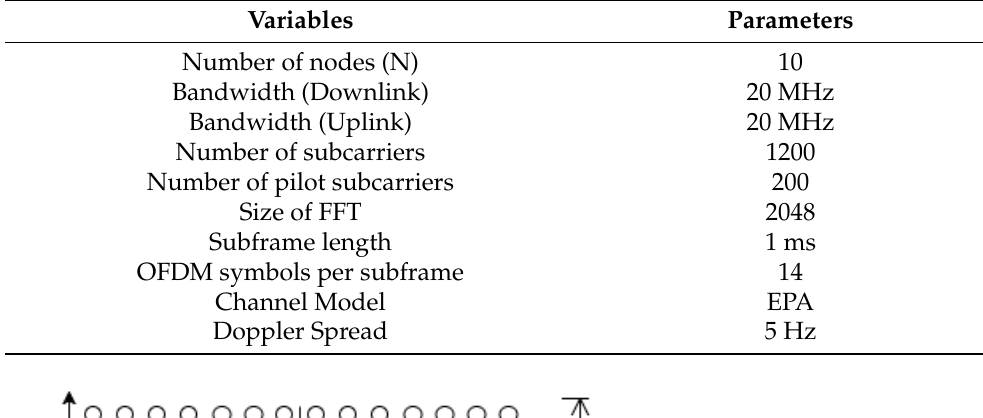
Figure 5. Proposed comb type pilot arrangement for channel estimation over OFDM grid. Table 2. Link-level system parameters.